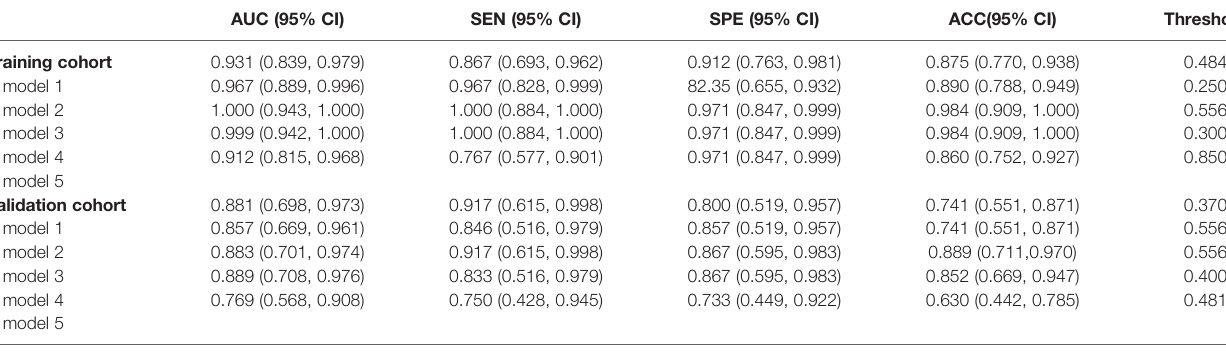
The data shown in brackets represent the 95% con fi dence intervals (CIs). model1 =Radiomics model_IVC; model2= Radiomics model_TT;model 3=Combined model_IVC; model4 =Combined model_TT; model5= Radiologicalmodel; AUC, areaunderthe curve; ACC, accuracy; SEN, sensitivity; SPE, speci fi